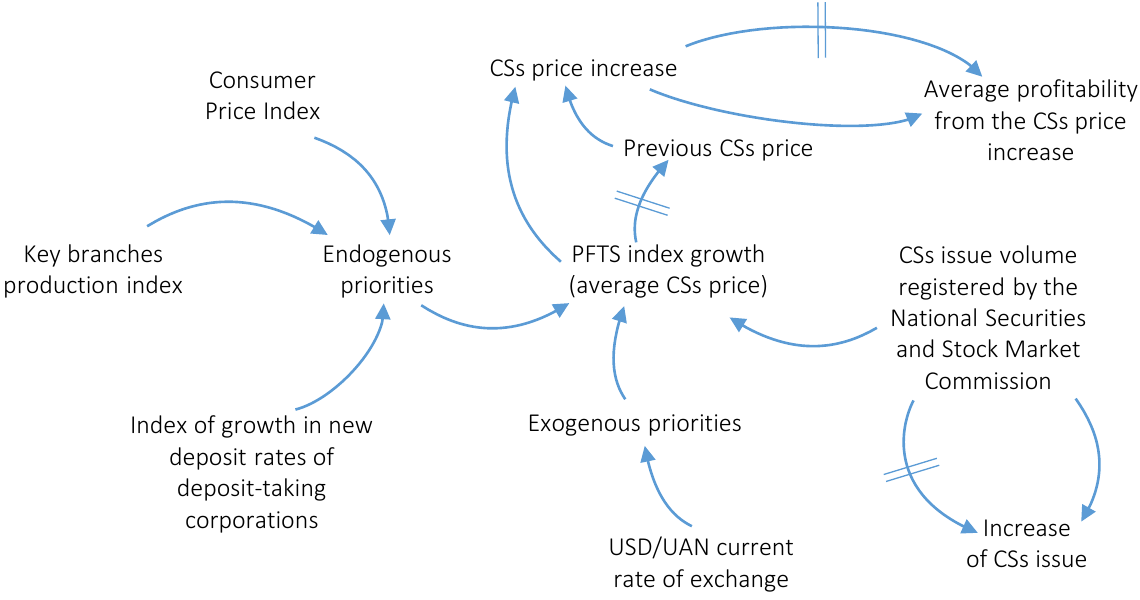
Figure 3. Causal relationships of the descriptive model of the Ukrainian CSs market